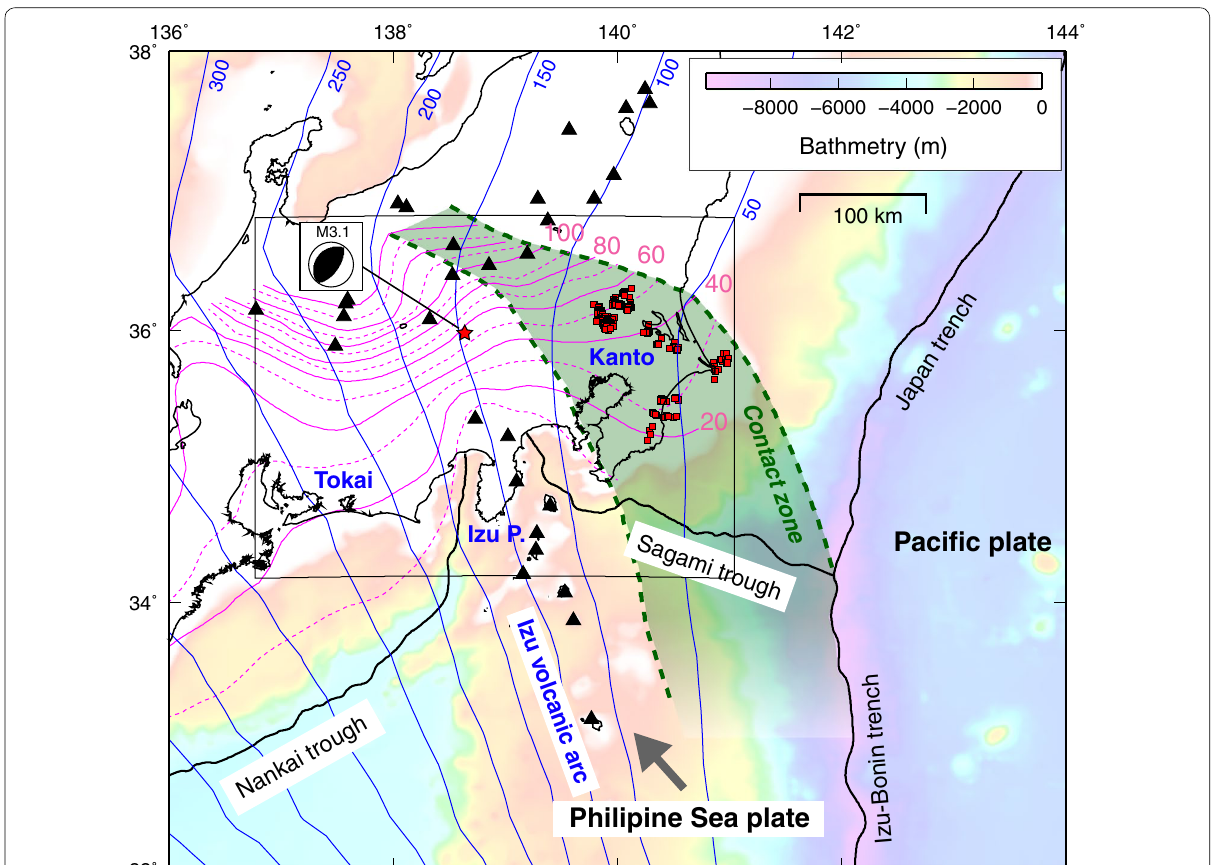
Fig. 1 Tectonic setting of central Japan with seafloor topography. Pink and blue lines denote iso-depth contours of the PHS Plate (Hirose et al. 2008; Nakajima et al. 2009) and Pacific Plate (Nakajima et al. 2009), respectively. Green shading represents an area where the bottom of the PHS Plate is in contact with the upper surface of the Pacific Plate (Nakajima et al. 2009; Uchida et al. 2009). Black triangles denote active volcanoes. Red squares represent the epicenters of thrust earthquakes that occurred along the upper surface of the PHS Plate. The red star denotes the epicenter of the M3.1 earthquake analyzed in this study. The focal mechanism of the M3.1 earthquake, as determined by the Japan Meteorological Agency (JMA), is shown in an equal-area lower-hemisphere projection. Gray arrow shows the relative plate motion of the PHS Plate with respect to the continental plate. The rectangle shows the area highlighted in Fig.